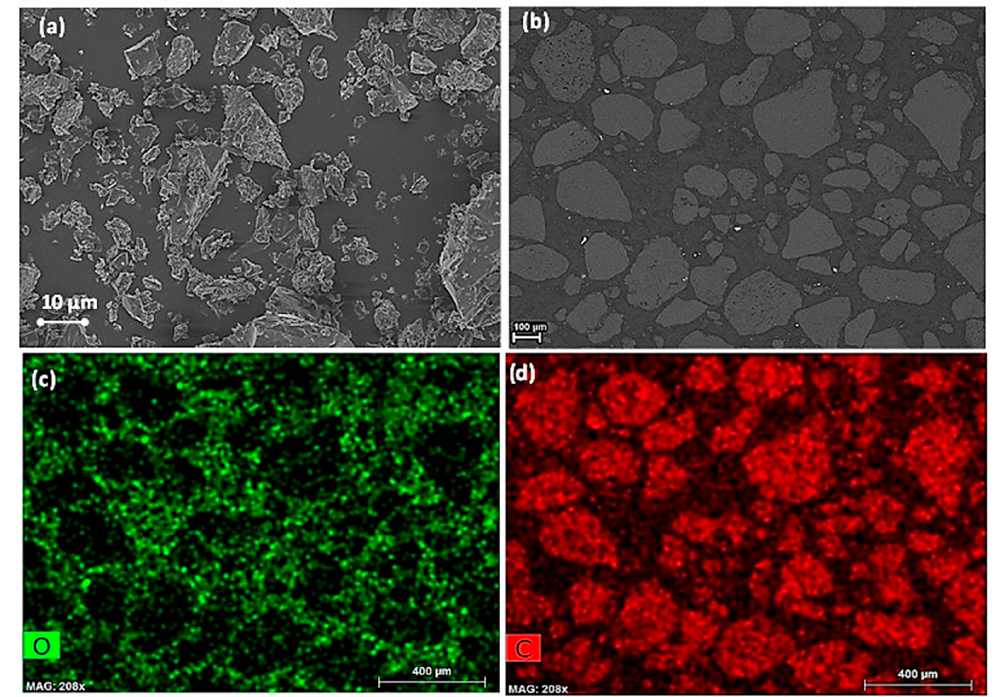
Figure 7. Microstructure analysis and elemental composition/distribution in c-PET particles obtained by direct carbonization of w-PET: ( a ) FIB-SEM image showing the 3D surface of c-PET particles (at 1000 × magnification); ( b ) SEM image of the cross-sectional area of c-PET particles generated from image ( b ); ( c ) SEM-EDX elemental map of elemental oxygen atoms; and ( d ) SEM-EDX elemental map of elemental carbon atoms generated from image ( b ).